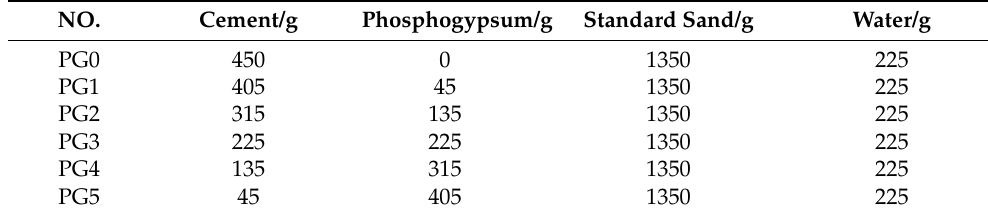
Table 2. Mix of mortar with cement and red